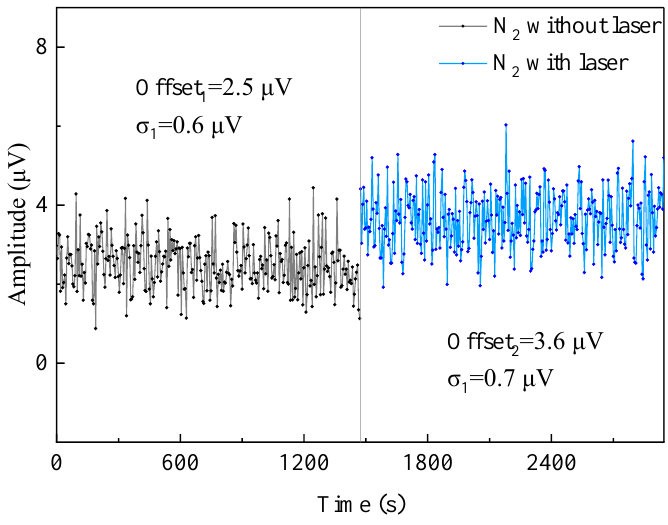
Figure 7. Influence of incident laser on system noise.